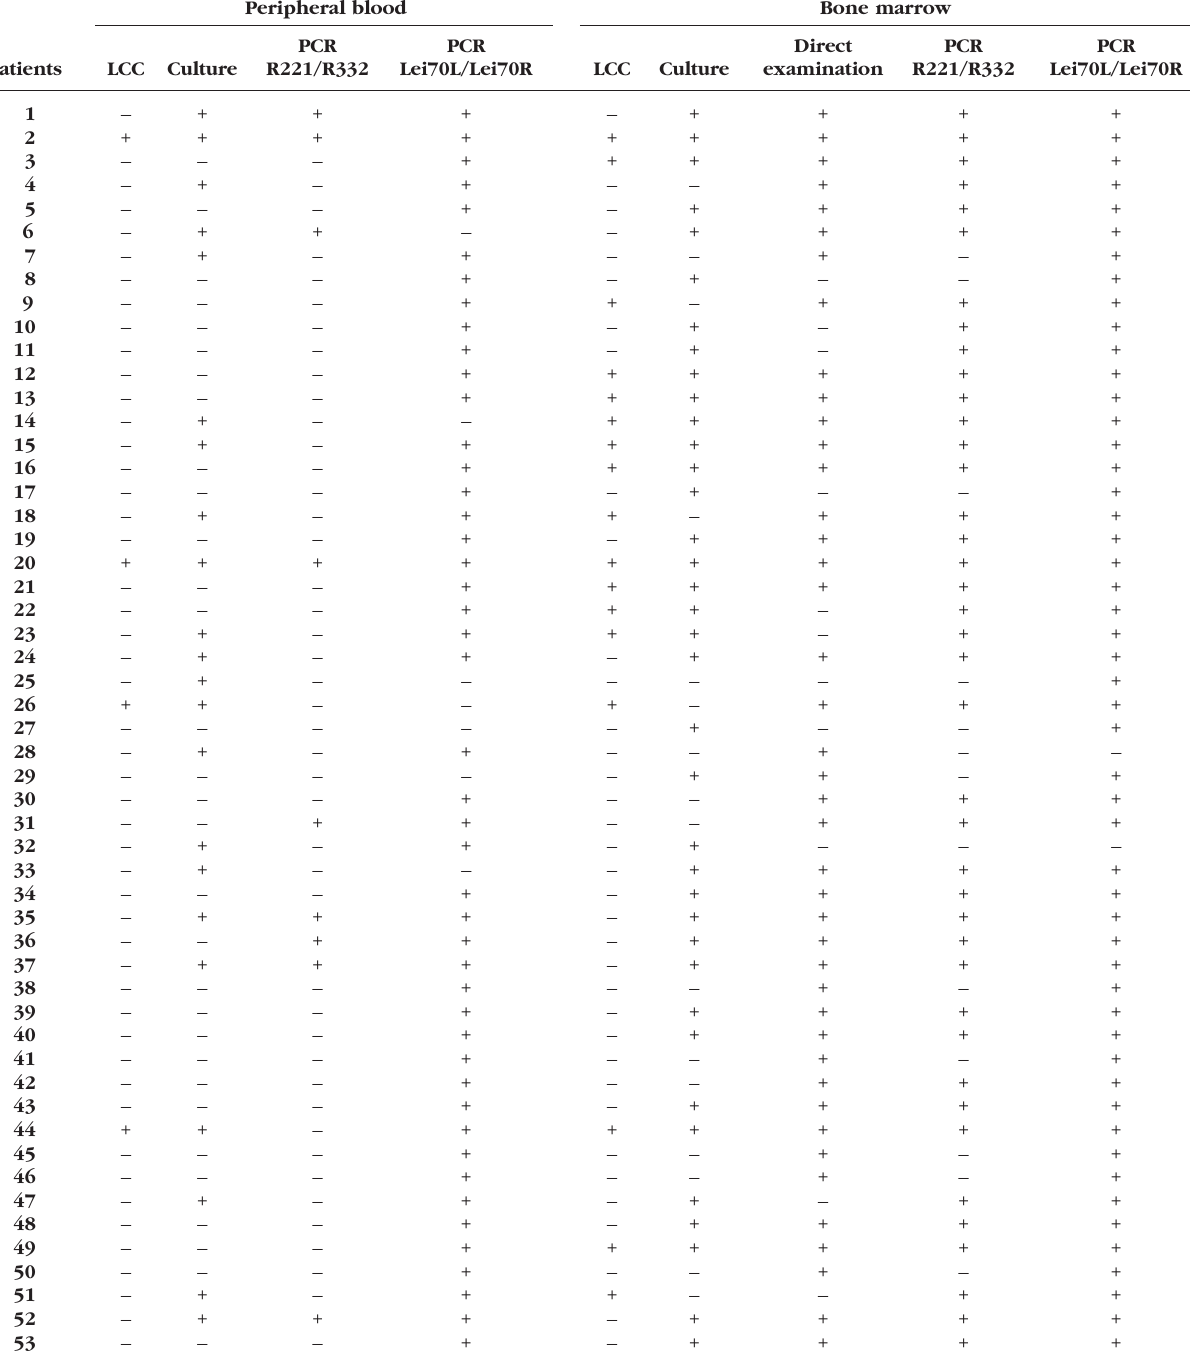
Table I. – Results of PCR assays and classical methods for peditaric visceral leishmaniasis